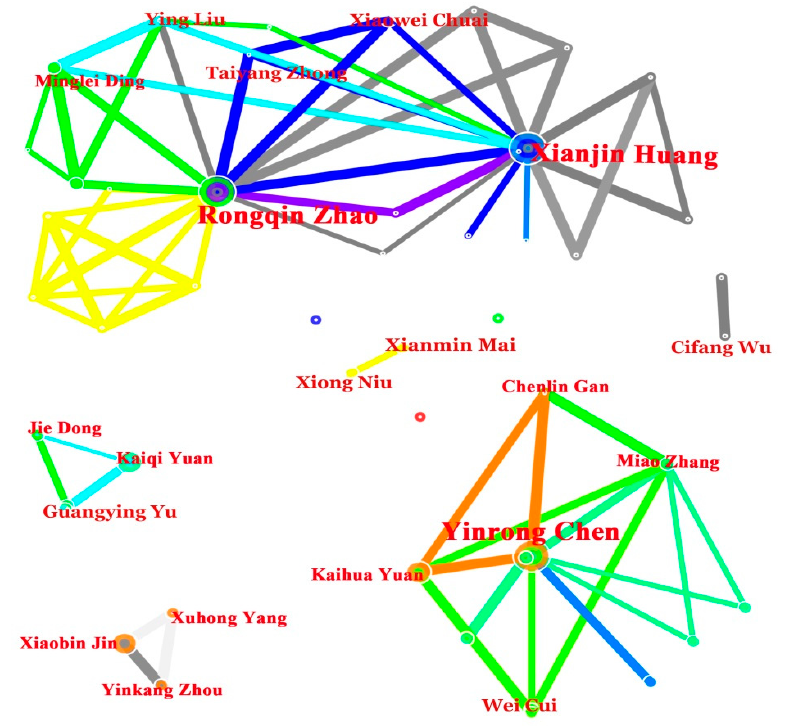
Figure 6. The collaborative network of authors for carbon emissions research in the CNKI database.